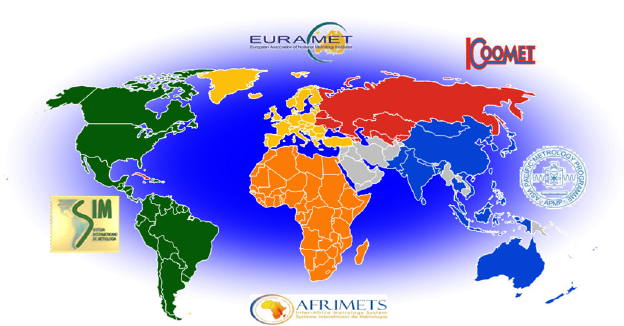
Fig. 3. RMOs around the